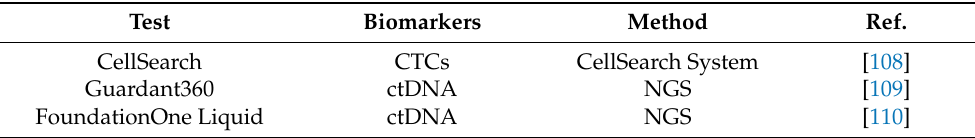
Table 5. FDA-approved tests using liquid biopsy for breast cancer. Test Biomarkers Method